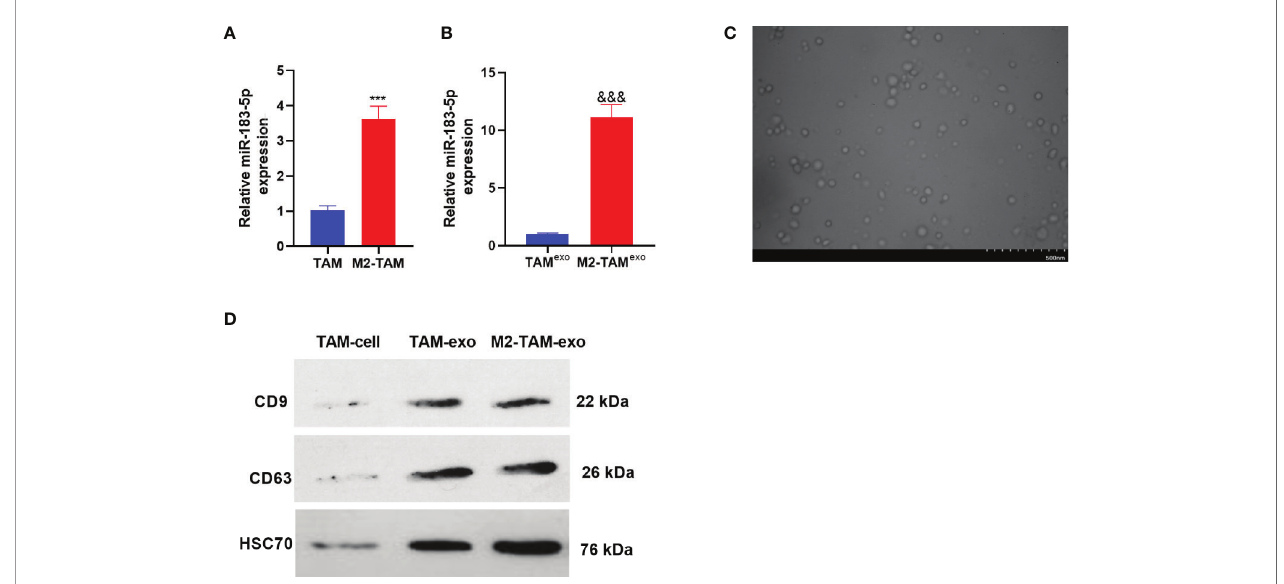
FIGURE 2 | MiR-183-5p was enriched in M2-TAM-Exo. The miR-183-5p expression in M2-TAM was detected. (A, B) The pro fi les of miR-183-5p in TAM, M2-TAM and TAM-Exp/M2-TAM-Exo were compared by qRT-PCR. (C) TAM and M2-TAM-Exo were identi fi ed by Electron microscopy. (D) WB was implemented to verify the exosome surface markers CD9, CD63 and HSC70. *** P < 0.001( vs . The TAM group), &&& P < 0.001( vs . the TAM exo group).